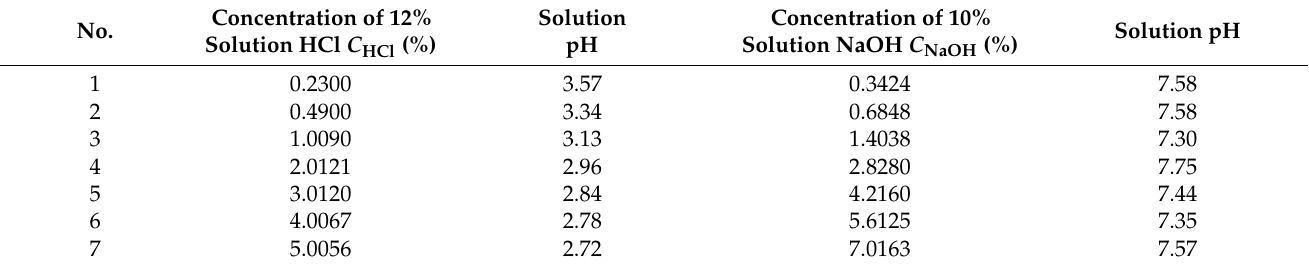
Figure 5. Raman spectra of the compounds formed in the polymer composition without a gelation gel-time modifier ( a ) and in the developed polymer composition ( b ). Table 1. PH values at the different contents of the gelation delayer and neutralizer